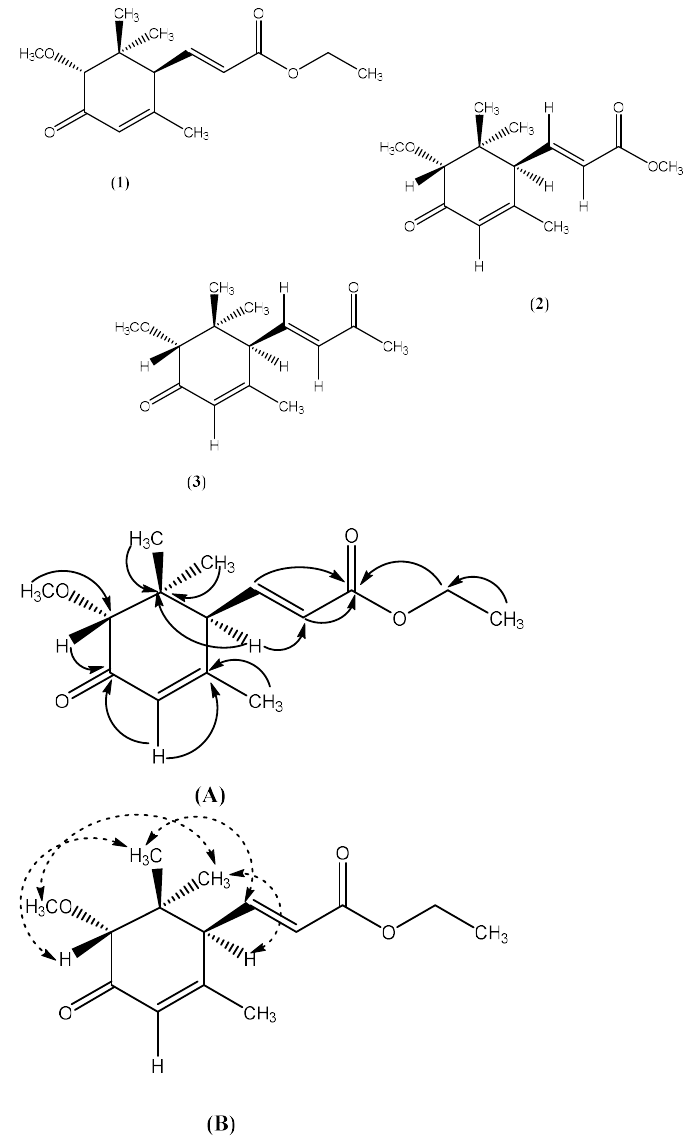
Figure 1. Chemical Structure of Compound 1 , 2 and 3 . ( A ). Important HMBC correlations ( ), ( B ). NOE correlation ( ).